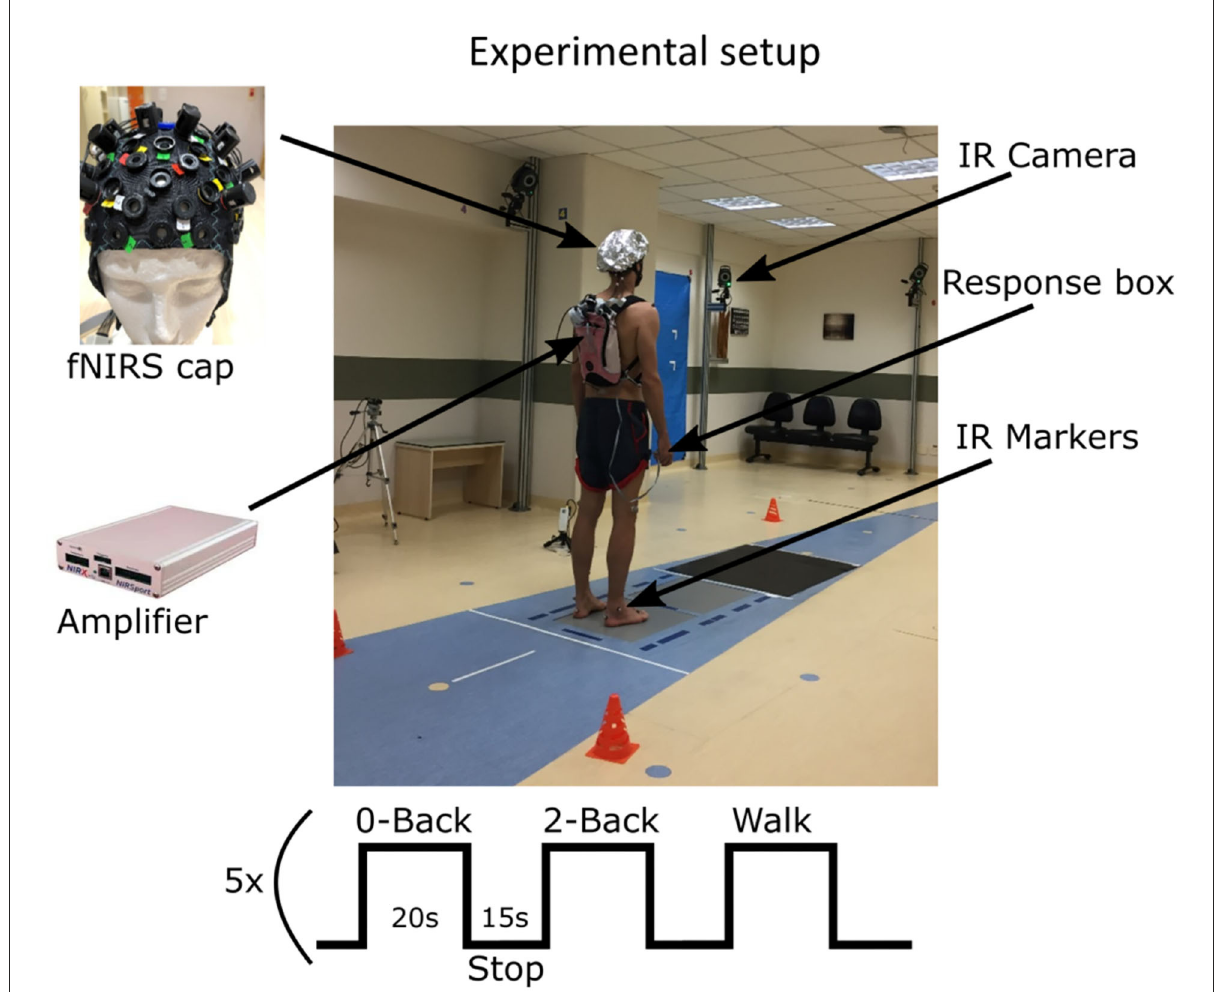
FIGURE1 Block design and participant preparation in the gait lab. All participants walked barefoot and in gym clothes, as standard in gait analysis